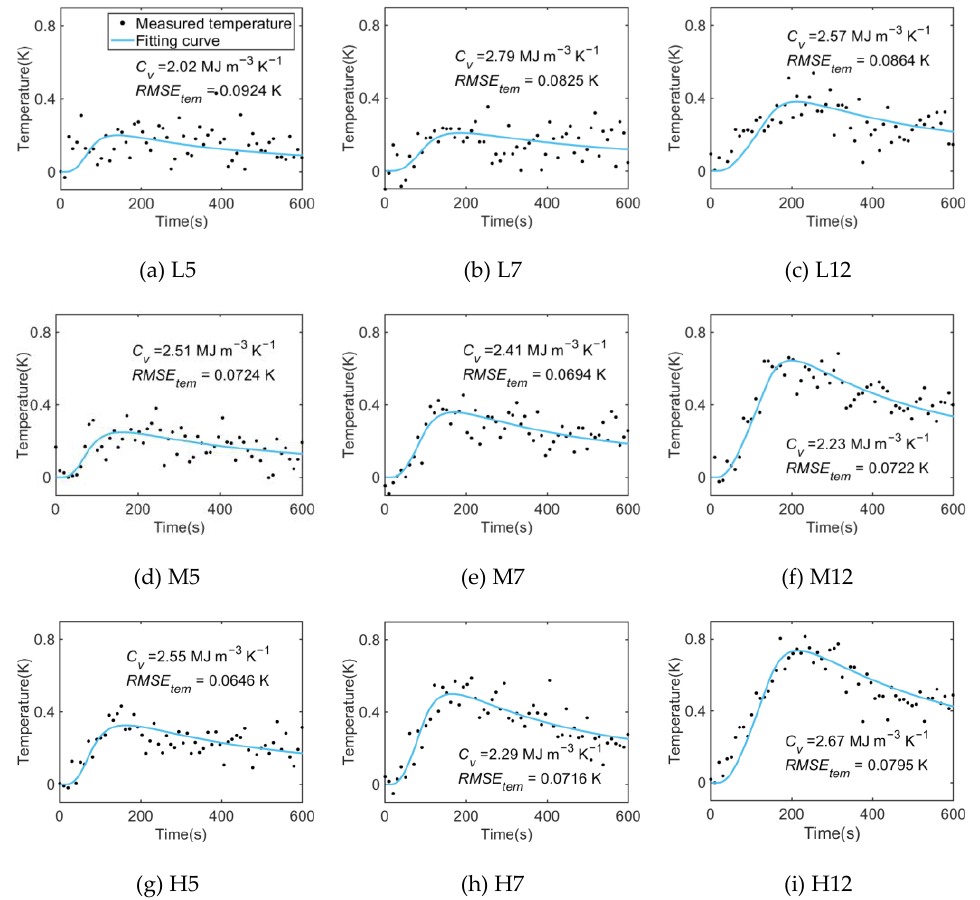
Figure 5. Fitting curves of the loess heat pulse process under different heating strategies.